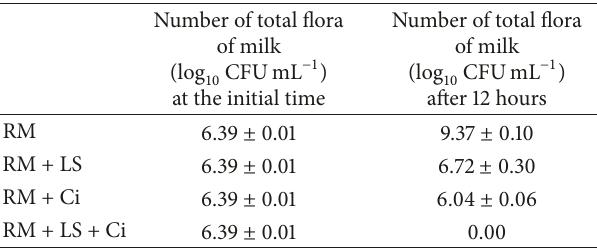
Table 1: Efficacy of the lactoperoxidase system and cinnamon essential oil in inhibiting the growth of total flora of